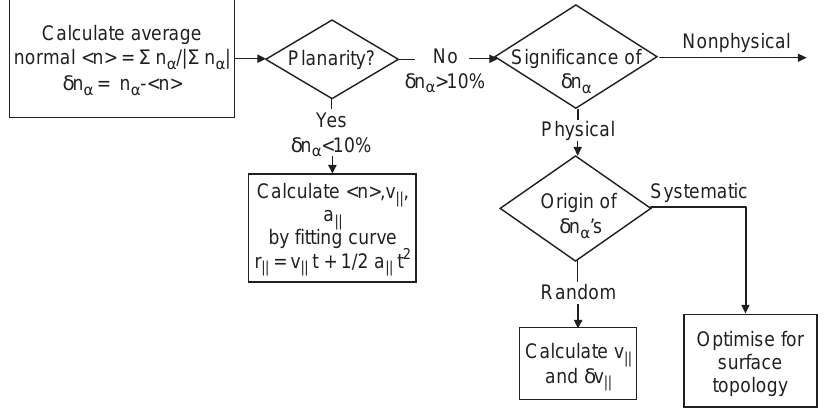
Fig. 2. The boundary normal analysis flow- chart, taken from Dunlop and